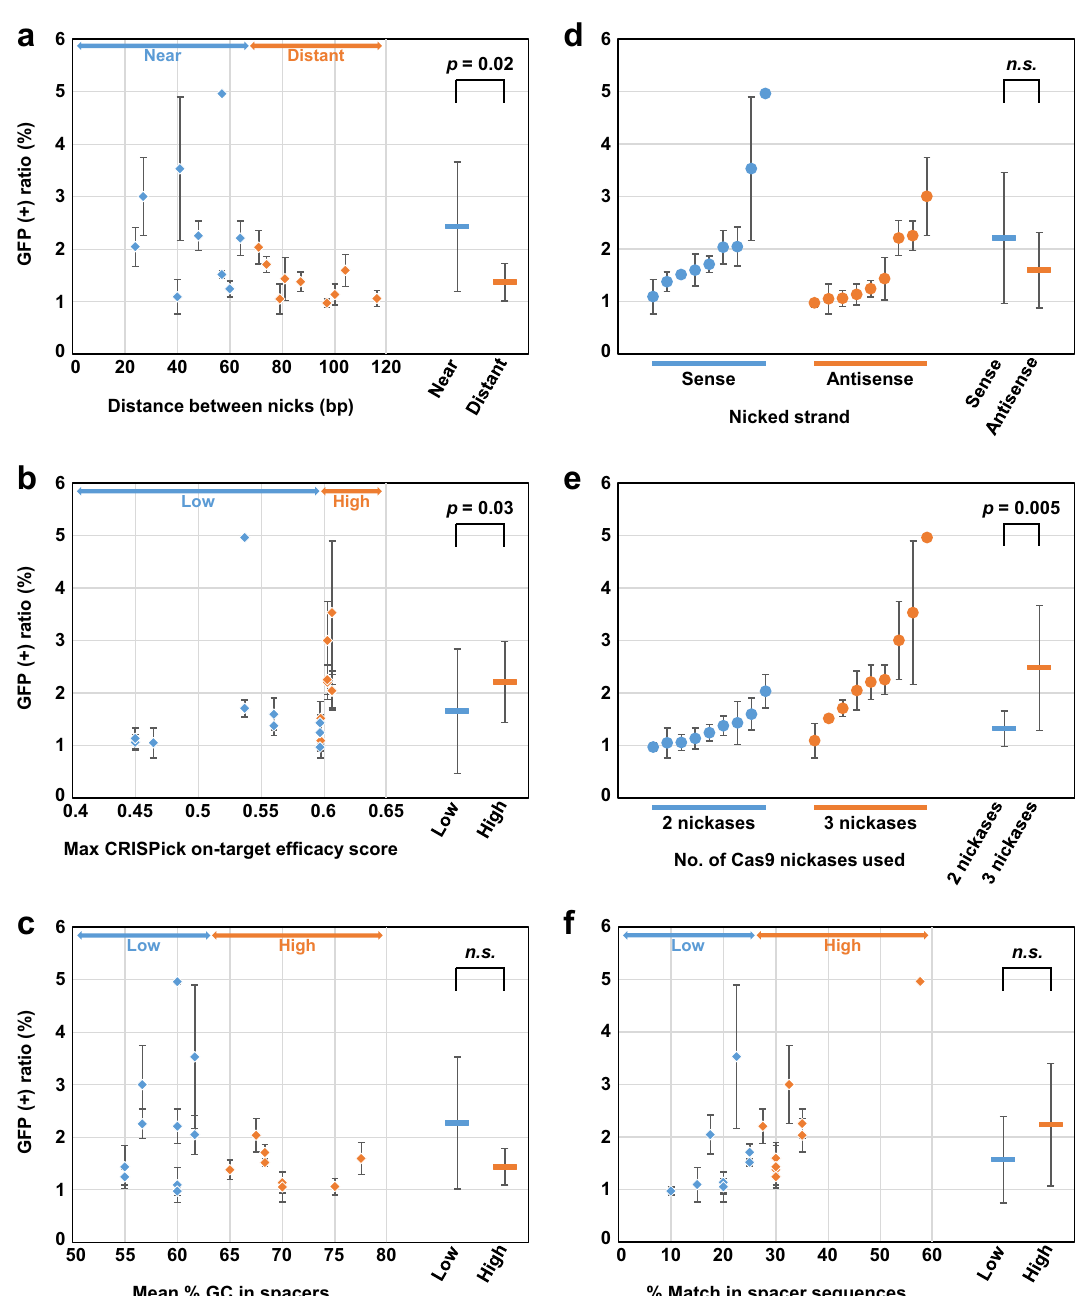
Figure 3. Higher CRISPick on-target efficacy scores, in addition to a shorter distance between two nicks, is a key factor to conduct efficient targeted knock-in via TPN. An HCT116-based reporter cell clone, HCT116- rNCO, was transfected with Cas9 nickases designed against the EGFP gene within a 70-bp range from the knock-in site, and analyzed by FCM (also see Supplementary Fig. S3a,b for experimental details). The ratios of GFP-positive cells are plotted on the graphs with x-axes indicating (a) distances between nicks, (b) the maximum CRISPick on-target efficacy scores among those of two or three spacers used, (c) the mean percentages of GC content in two or three spacers, (d) nicked strands, (e) the numbers of Cas9 nickases used, and (f) the percentages of identical nucleotides within spacers. In ( f ), when three Cas9 nickases were used and two spacers designed against the same position in the wild-type and mutant EGFP, respectively, showed different percent identities to the remainder of three spacers, the average percent identity was calculated and used for data plotting. In ( a – f ), the average data obtained from three independent experiments were determined for individual 18 sgRNA combinations [depicted by squares ( a – c , f ) or circles ( d , e )], divided into two groups at the median values on x-axes ( a – c , f ) or by the indications on x-axes ( d , e ), and then statistically analyzed as summarized to the right in the respective graphs. All error bars in ( a – f ) represent standard